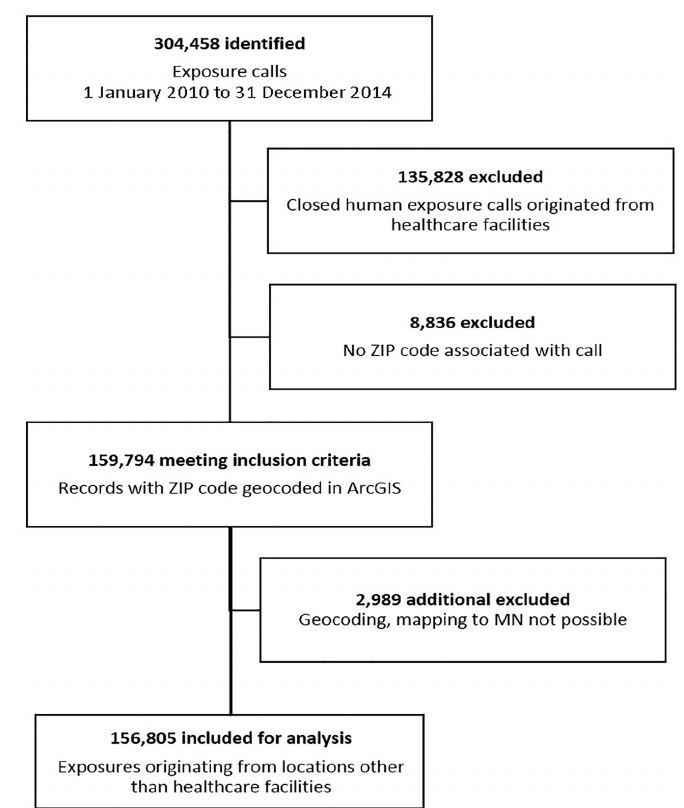
Figure 1. Study flow diagram of phone calls made to Minnesota Poison Control System, using geospatial analysis to pinpoint